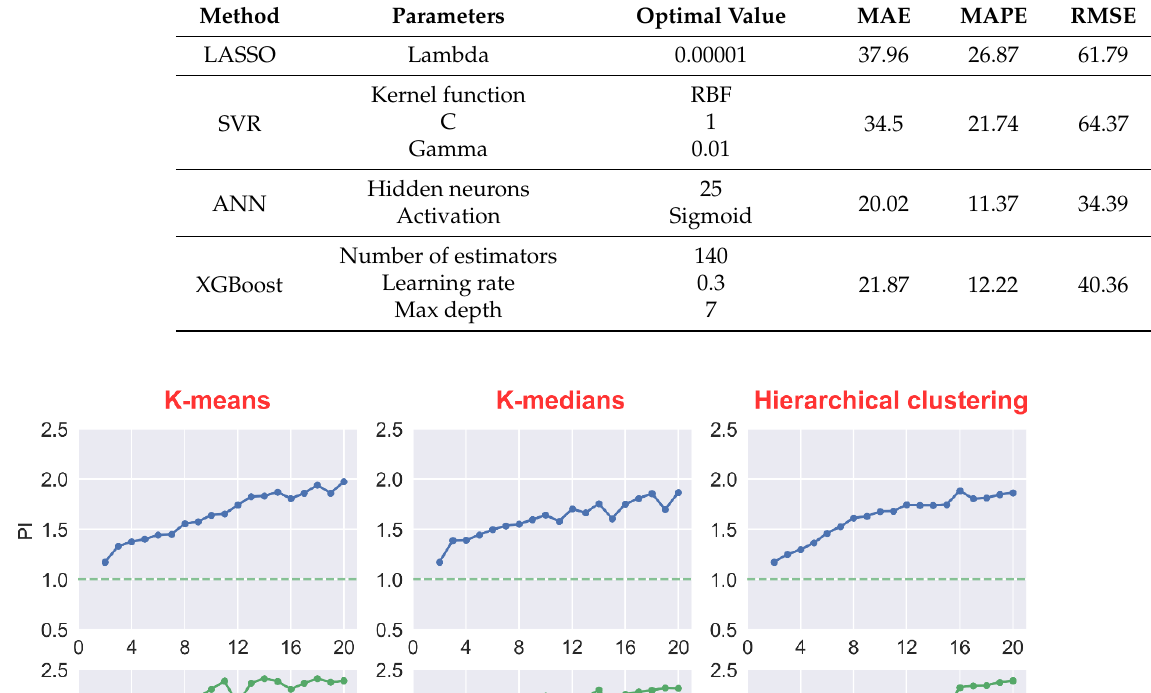
Figure 8. Three columns indicate three clustering algorithms and four lines indicate four regression models. Table 3. Parameters optimization result and performance of different regression models.